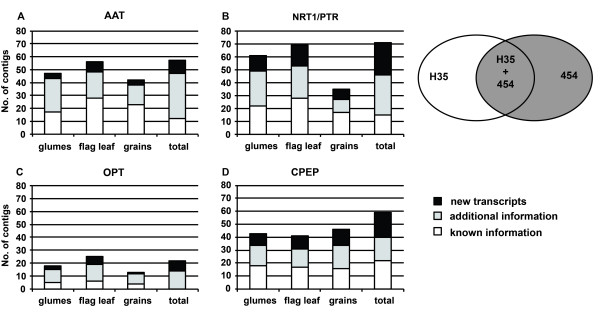
New sequence information for N transporter and cysteine peptidase genes. Comparison of RNA-seq and H35 unigenes for (A) AAT, (B) NRT1/PTR and (C) OPT transporter sequences and for (D) cysteine peptidase unigenes. New information (black areas) from RNA-seq shows less than 98% identity to H35 unigenes at amino acid level. Additional information (gray-shaded) matches H35 unigenes, but extends information by more than 50 bp or closes gaps between unigenes. Known information (white areas) did not add new knowledge. Origin of sequences is represented by gray-shaded areas of the overlapping ellipses at the right side.